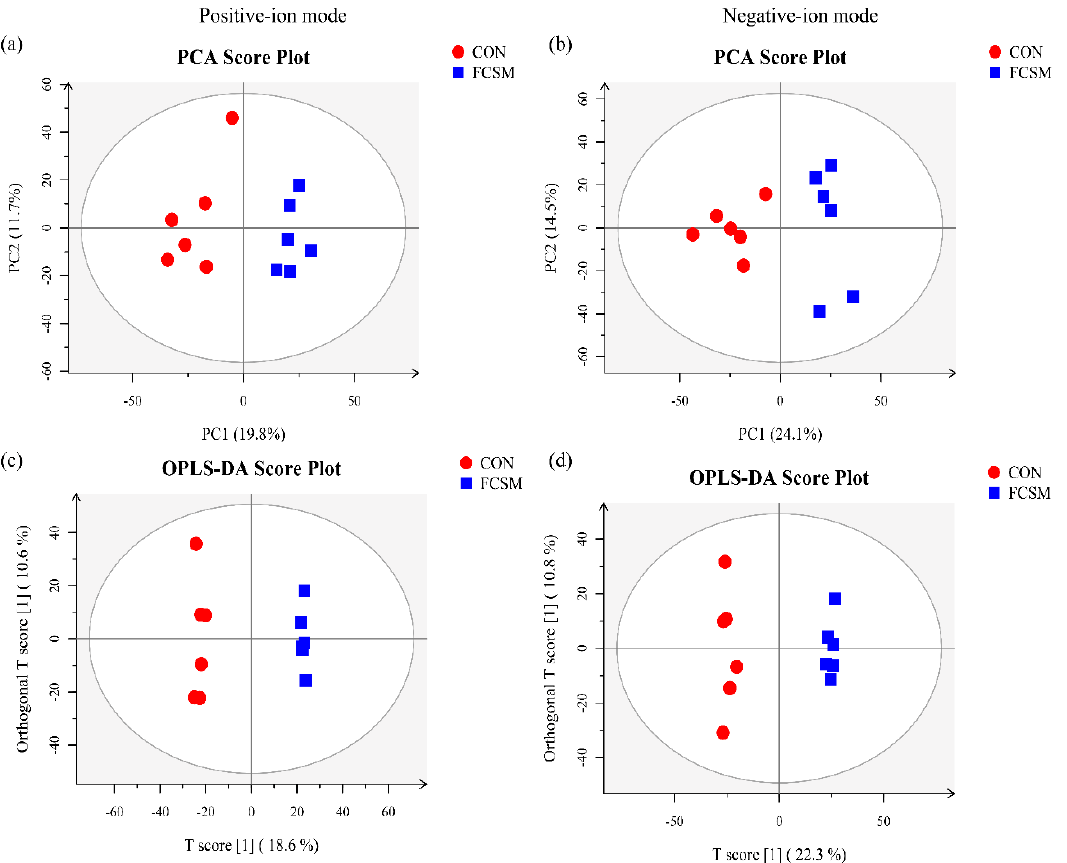
Figure 2. Principal component analysis (PCA), and orthogonal projections to latent structures- discriminant analysis (OPLS-DA) score plots analysis of LC-MS/MS data in positive-ion mode and negative-ion mode between CON and FCSM groups. CON, no fermented cottonseed meal in diet; FCSM, 6% fermented cottonseed meal in diet. ( a ) principal component analysis (PCA) in positive-ion mode. ( b ) Principal component analysis (PCA) in negative-ion mode. ( c ) OPLS-DA score plots in positive-ion mode. ( d ) OPLS-DA score plots in negative-ion mode.